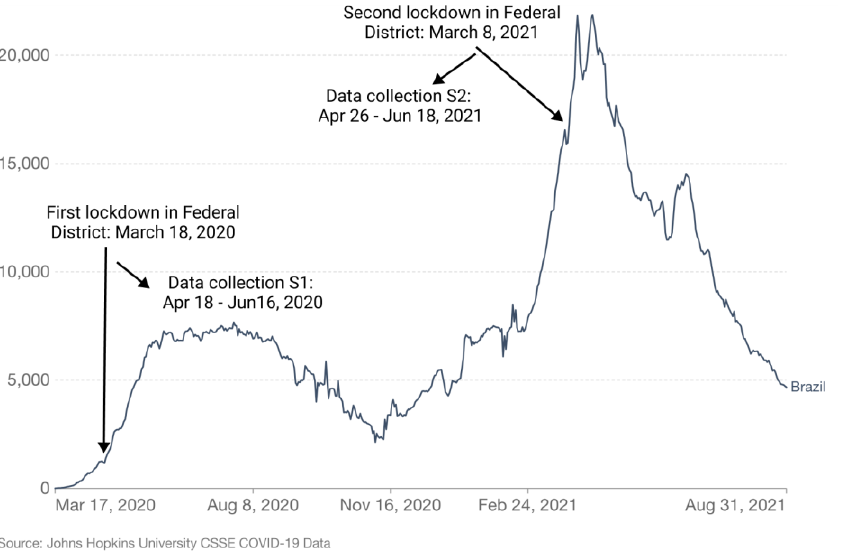
Figure 3. Weekly confirmed COVID-19 deaths in Brazil [56]. S1 = Study 1; S2 = Study 2.